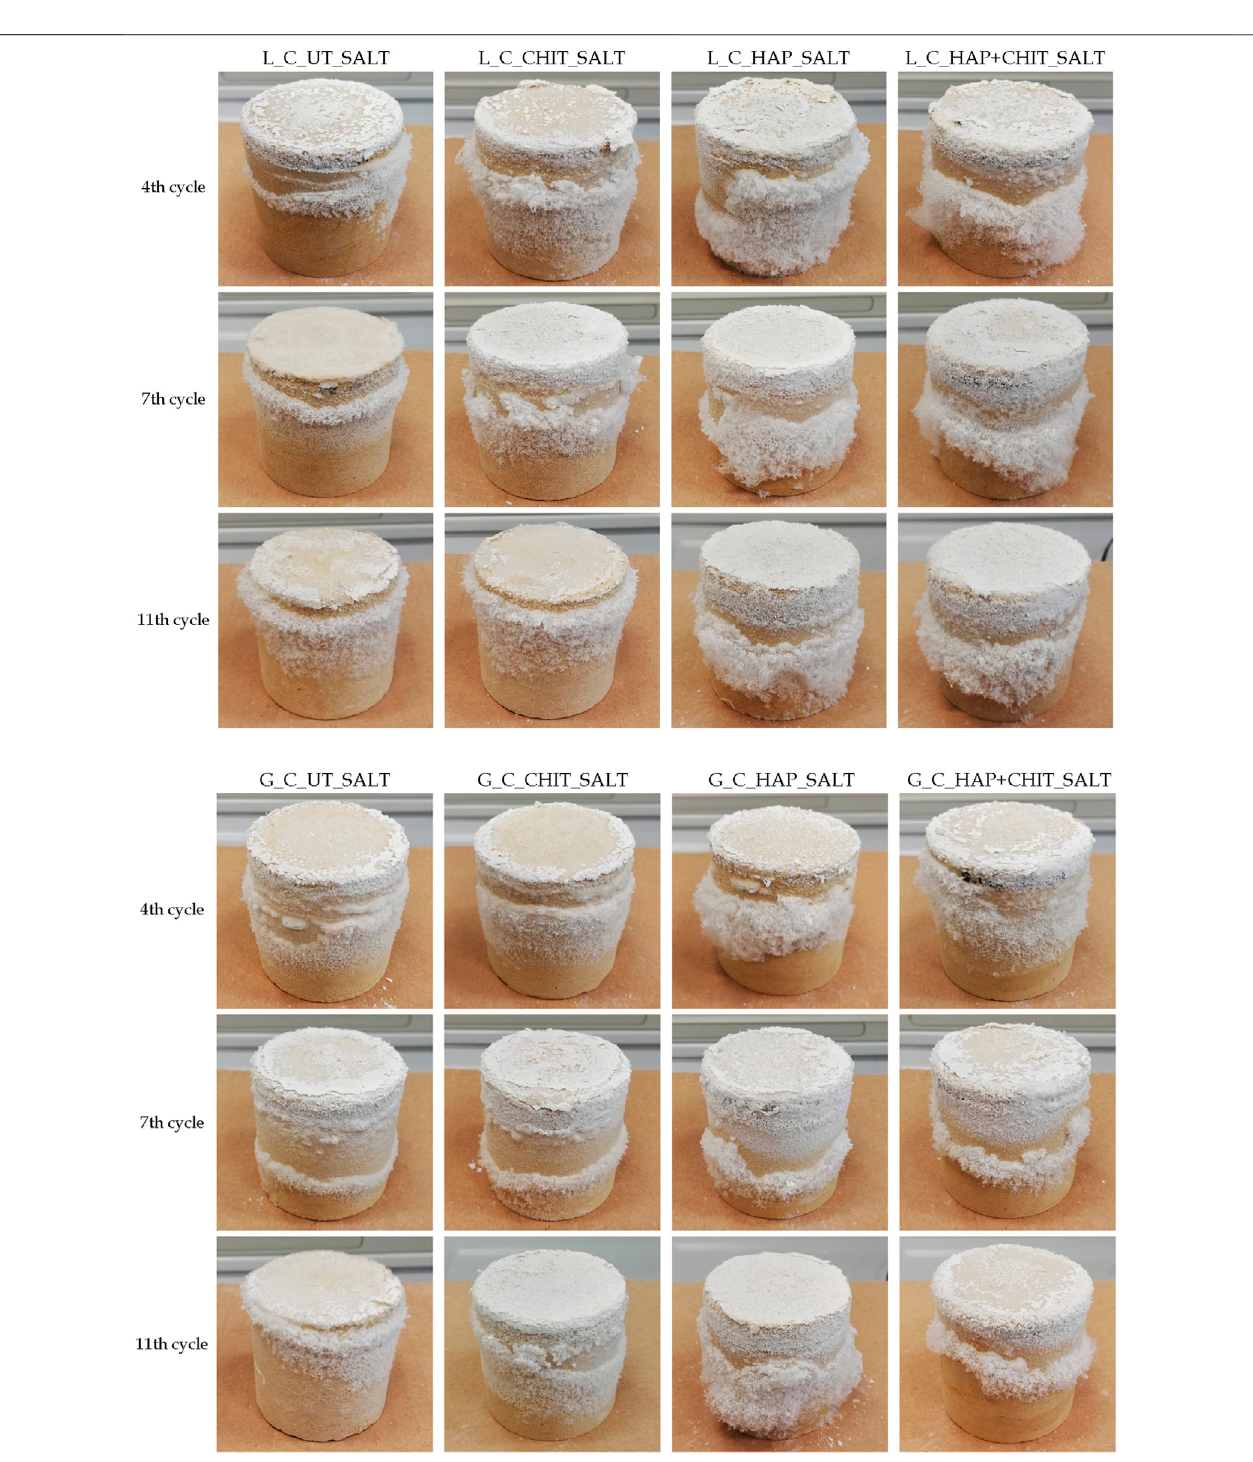
FIGURE 6 | Lecce stone samples and Globigerina limestone samples during the cycles (dried condition, before brushing), where the difference in the amount of ef fl orescence formed in the different type of samples can be seen. The pictures of the cycles with oven drying are not reported, because the “ cementi fi cation ” of debris during drying made impossible to distinguish the layer of ef fl orescence.